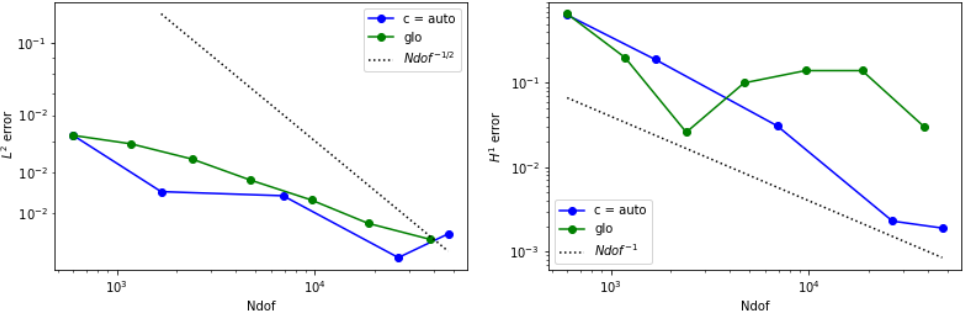
Figure 25. Error behavior for example 4 when η Z is adopted. ( Left ) The estimated L 2 norm of the error is displayed. ( Right ) The estimated H 1 seminorm is shown.